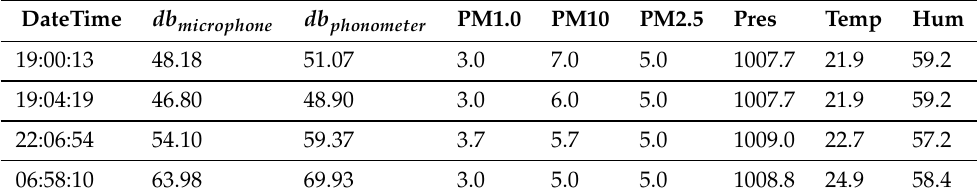
Table 4. Exemplary part of the second dataset.